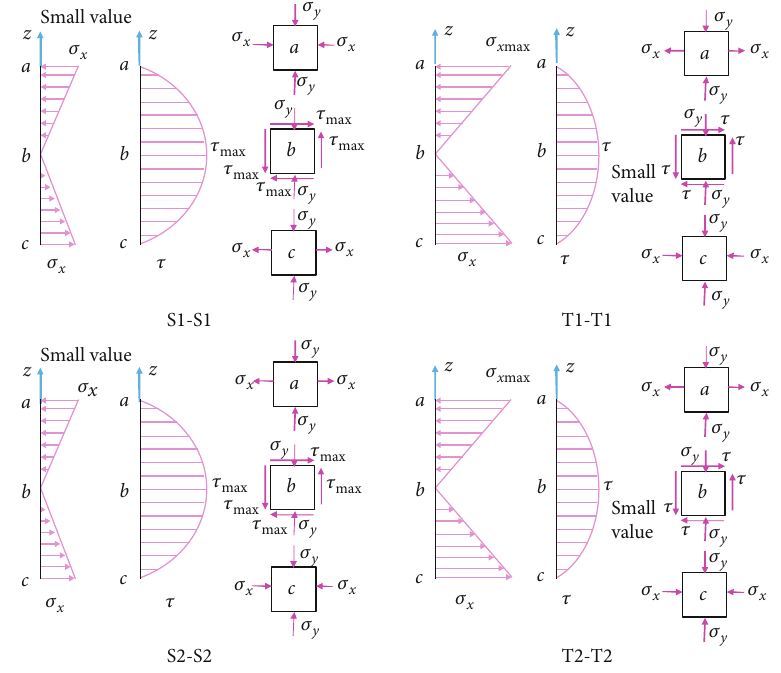
Figure 15: The horizontal stress, shear stress characteristics, and stress states of each